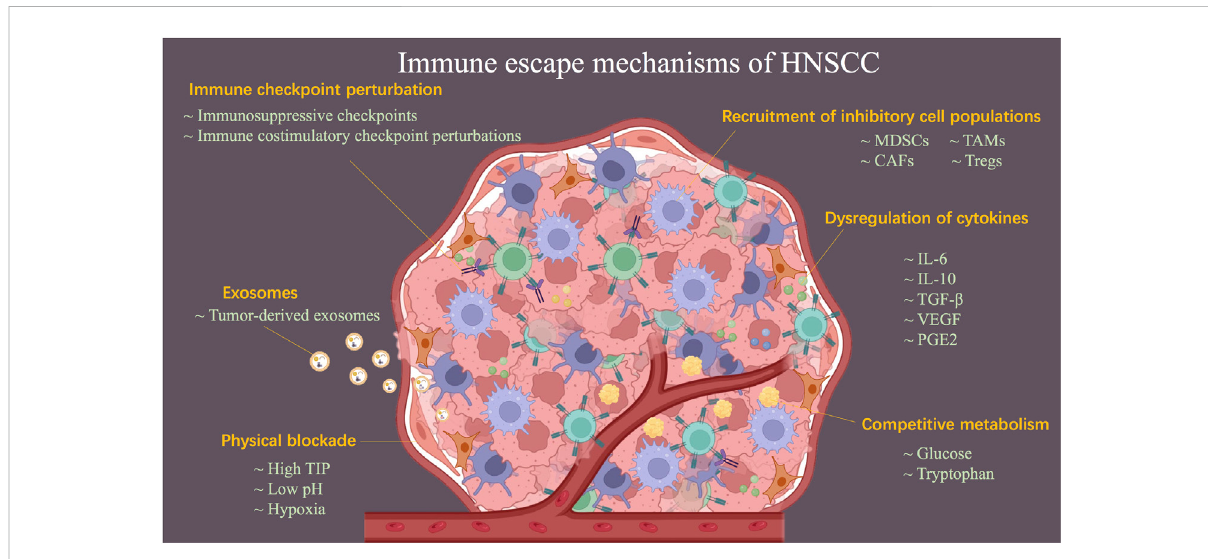
Schematic diagram describing the mechanisms of HNSCC-evaded immunity. Immune escape mechanisms, including physical blockade, dysregulation of cytokines, perturbation of immune checkpoint, recruitment of inhibitory cell populations, negative in fl uences of exosomes, and competitive metabolism of tumor cells, result in HNSCC becoming a refractory